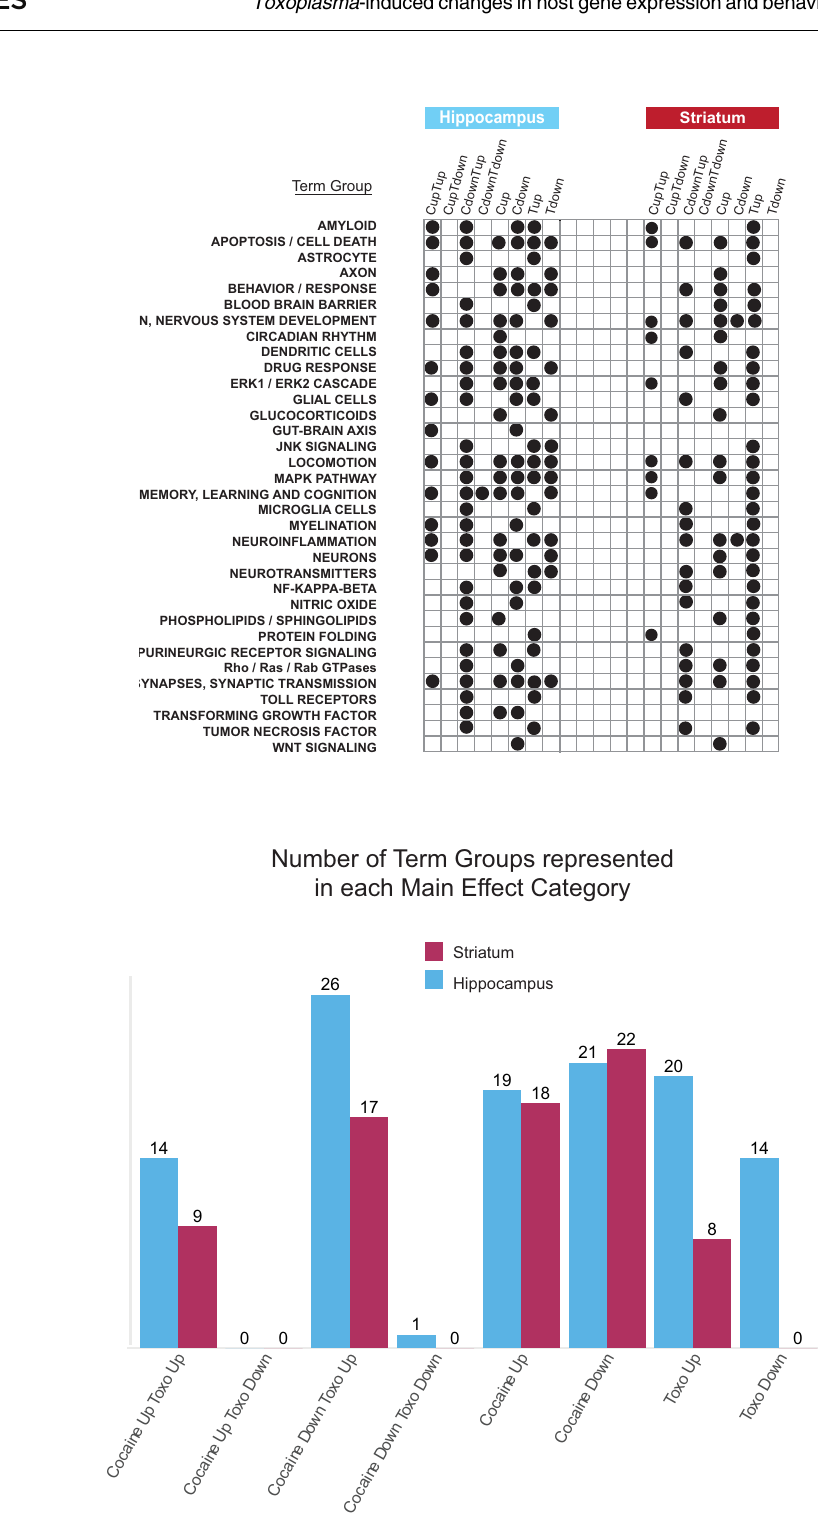
Fig 4. Summary of neurologically relevant, enriched annotations. A. Occurrence of neurologically relevant term groups across main effect and interacting effect categories in hippocampus and striatum. B. Number of term groups represented in each main effect category in each